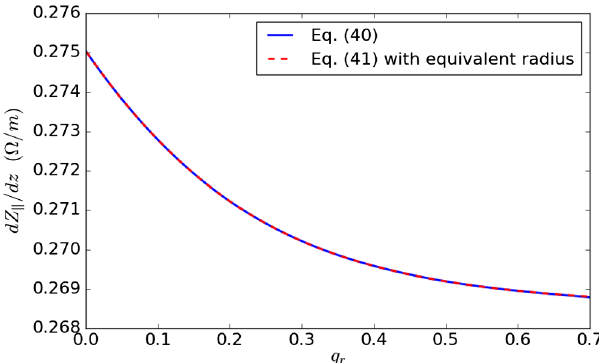
FIG. 8. Longitudinal indirect space charge impedance as a function of q r ¼ ð a − b Þ = ð a þ b Þ for the PS accelerator for a frequency of 100 kHz. Comparison between Eq. (40) and Eq. (41) by using the equivalent radius defined in Eq.